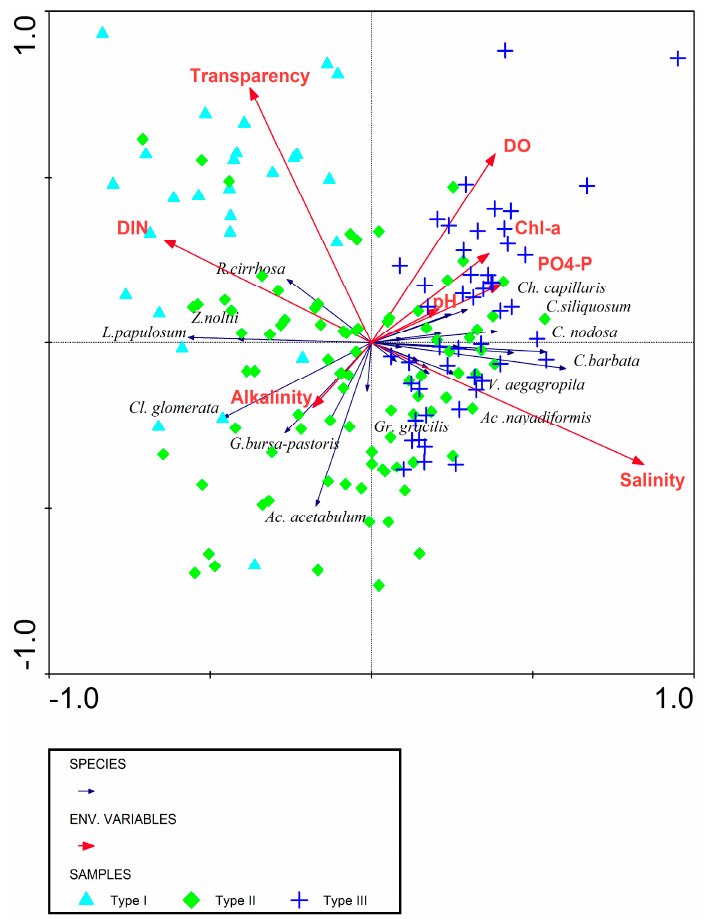
Figure 6. Graph plot of the redundancy analysis (RDA) conducted between environmental parameters and submerged macrophytes coverages in the three different lagoon types of Western Greece.